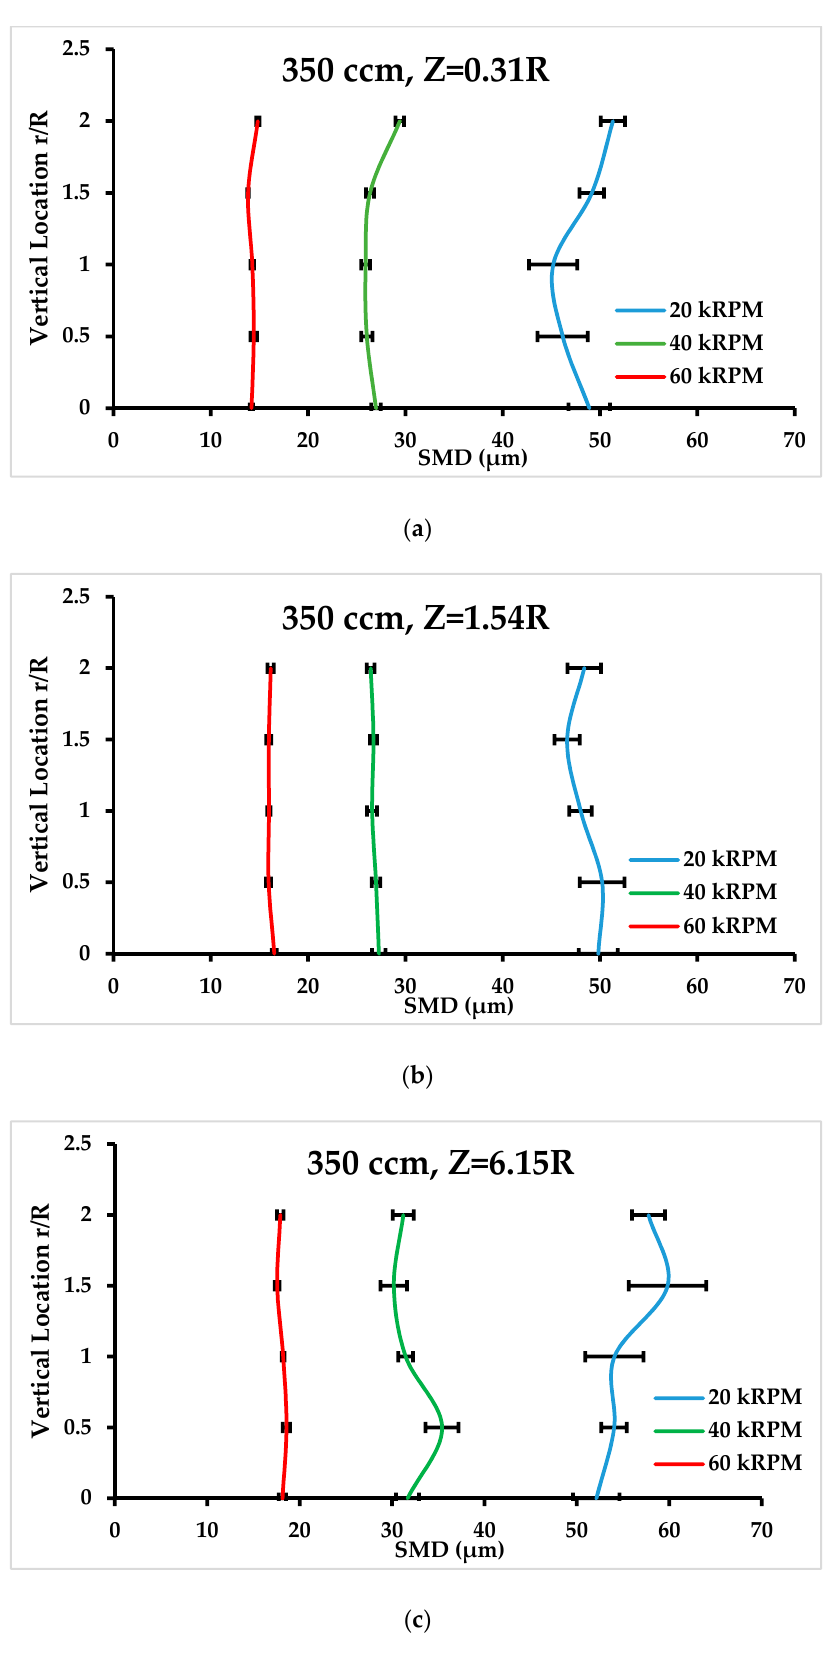
Figure 10. The SMD (D 32 ) plotted at the normalized vertical locations from the central (lateral) axis of the spray flow field, at different rotational speeds for a fixed fluid flow rate of 350 ccm.